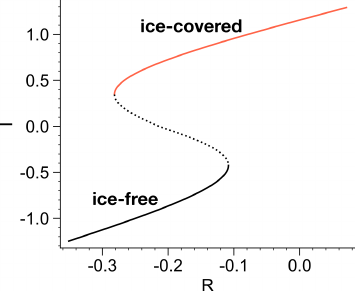
Figure 3. Bifurcation diagram of the sea ice component for param- eter values as in Table 1. The solid (dotted) lines indicate stable (unstable) fixed points. Table 1. Description of model